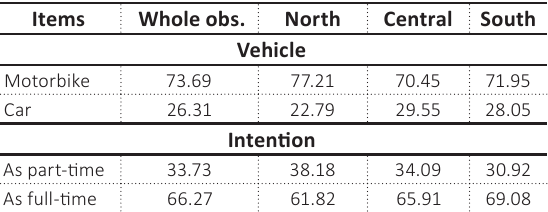
Table 2. Descriptive statistics for ridesharing